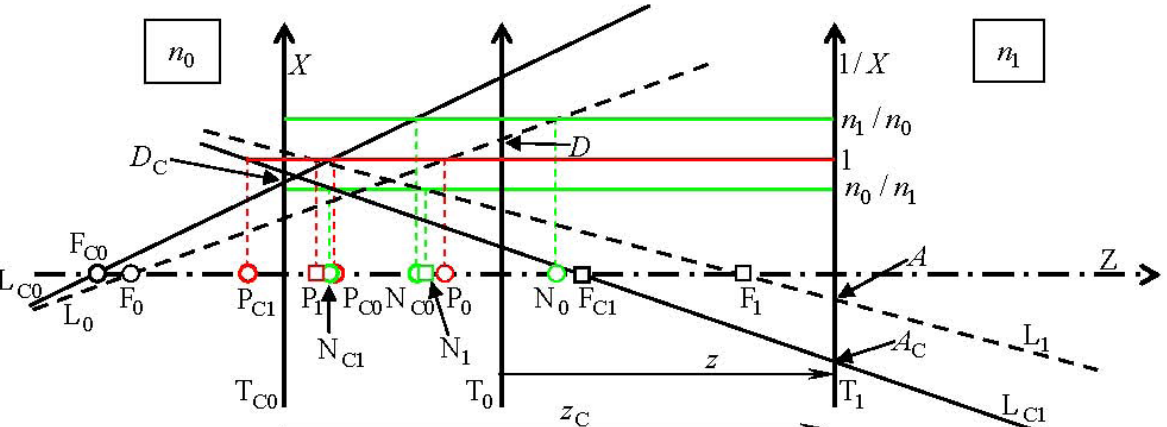
Figure 4 Combined system S C of length z C and with entrance plane T C0 and exit plane T 1 . It is the visual system S of Figure 3 with an optical device in front of it. Locator lines L 0 and L 1 of S become L C0 and L C1 of S C . Cardinal points F 0 , P 0 , N 0 , P 1 ,